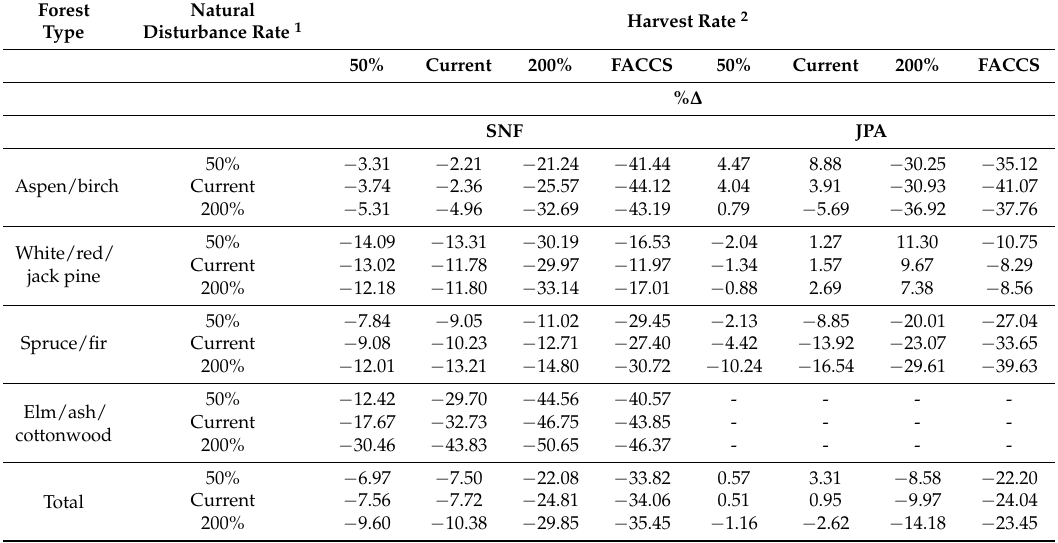
Table 2. Percent forest biomass stock changes (% ∆ ) on the Superior National Forest (SNF) and Jeanette Project Area (JPA) under three natural disturbance and four harvest scenarios after 120-year simulations. Initial biomass stocks can be compared with those presented in Table